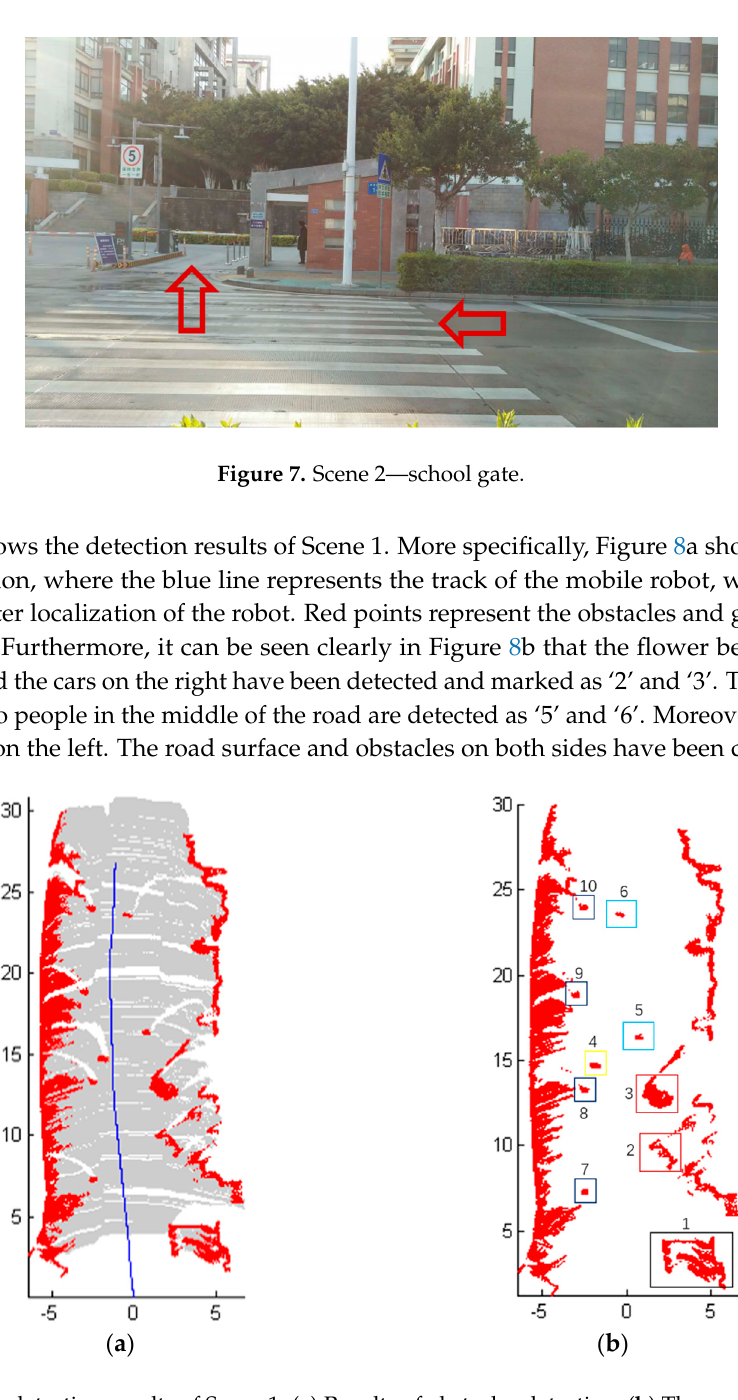
Figure 8. The detection results of Scene 1. ( a ) Results of obstacles detection; ( b ) The position of some objects which are detected.